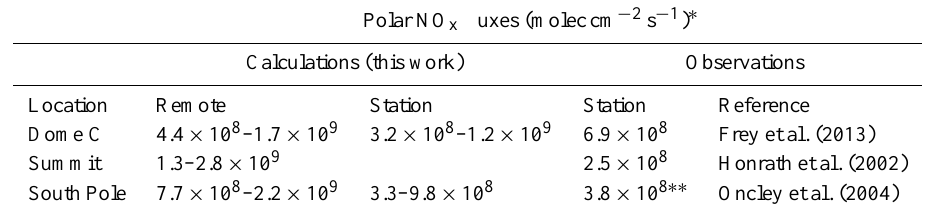
) near Dome C, Summit, and South Pole. x